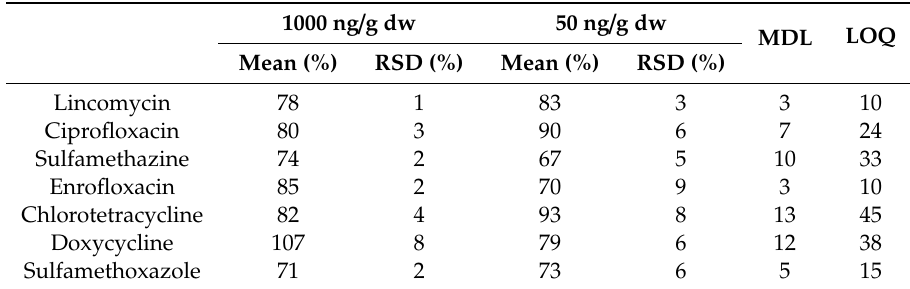
Table 1. Recoveries and relative standard deviations ( n = 4) obtained for the target antibiotics from lettuce spiked at two concentrations. Method detection limits (MDL) and limits of quantification (LOQ) obtained for the selected analytes (expressed in ng / g dw).